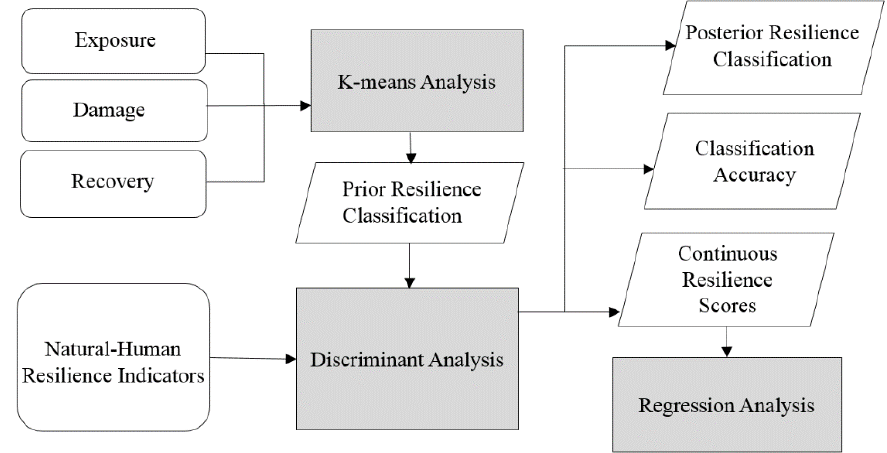
Figure 4. Flowchart of the procedure used in this study.